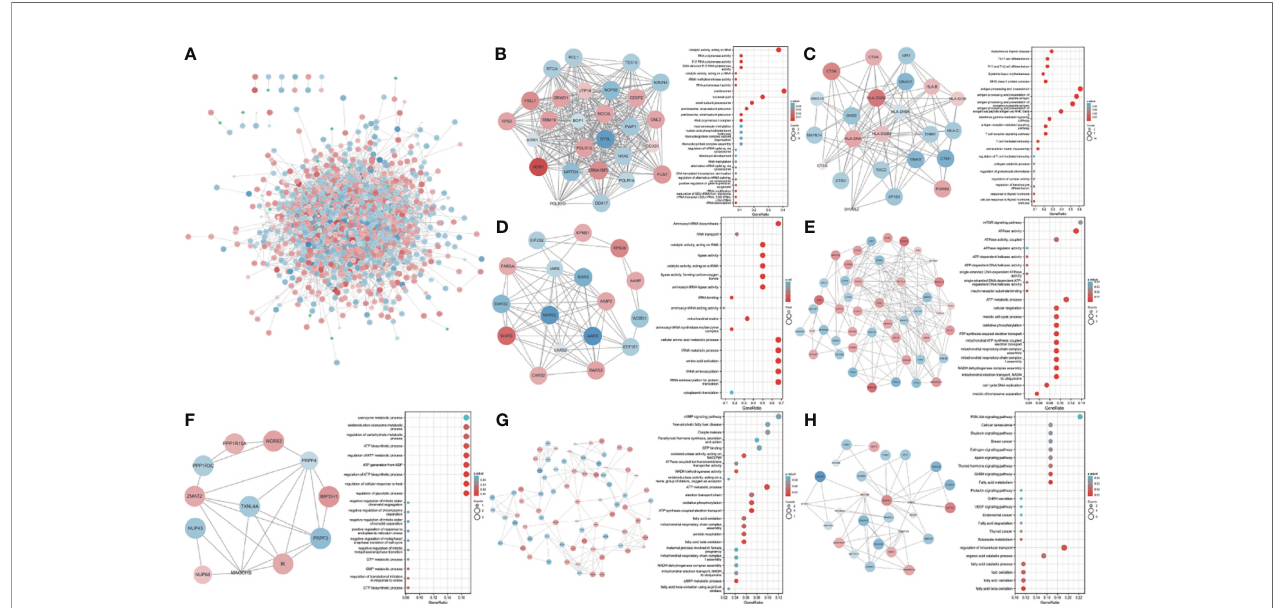
FIGURE 3 | PPI network and signi fi cant modules. Red and blue circles indicate upregulated and downregulated TWAS-identi fi ed genes. (A) PPI network of the TWAS-identi fi ed genes. (B-H) Signi fi cant modules 1 to 7 of the PPI network and their functional exploration. GeneRatio: the ratio of the number of genes associated with a term linked to an enriched gene to the total number of enriched